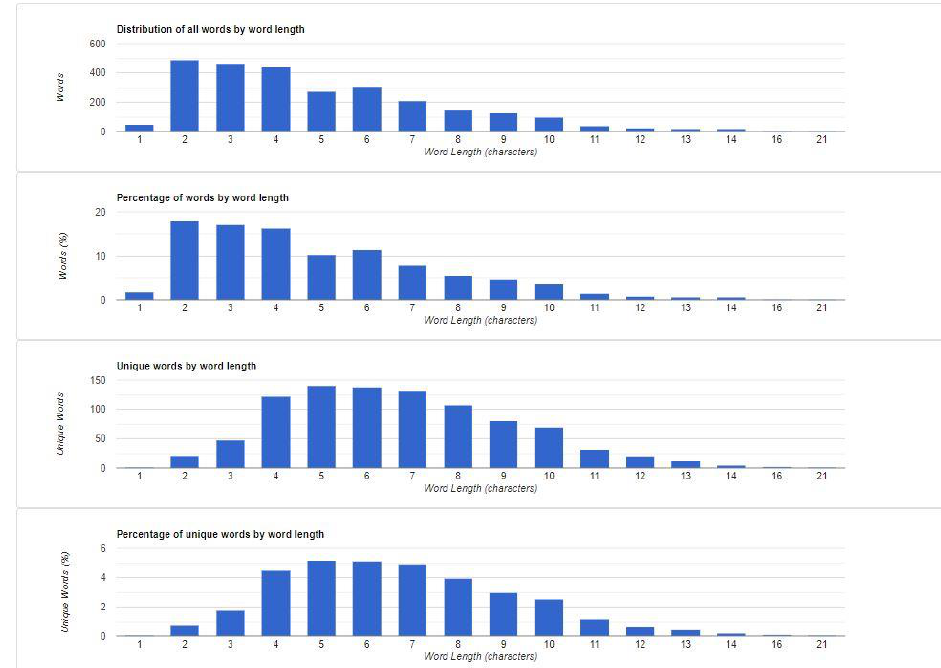
Figure 3. High Frequency Words in Storyboarding (Source: Voyant Tools). As shown in Figure 4, long words and unique words were relatively frequent in the storyboarding content.